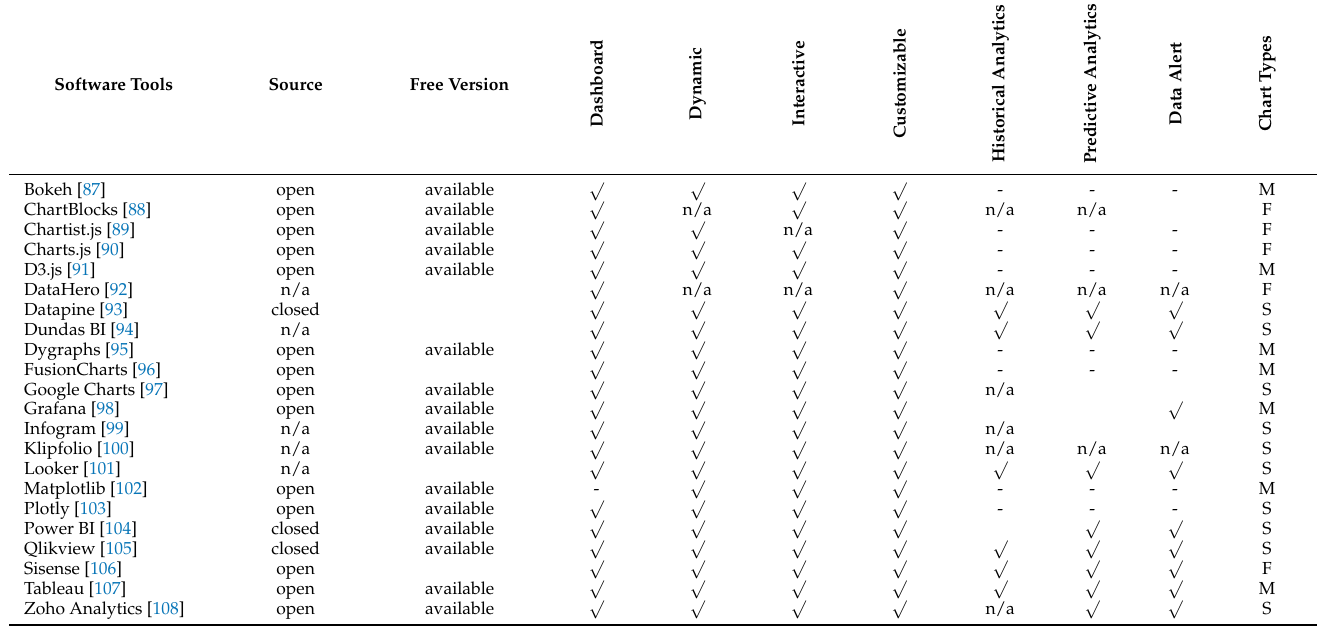
Table 3. Data visualization software development